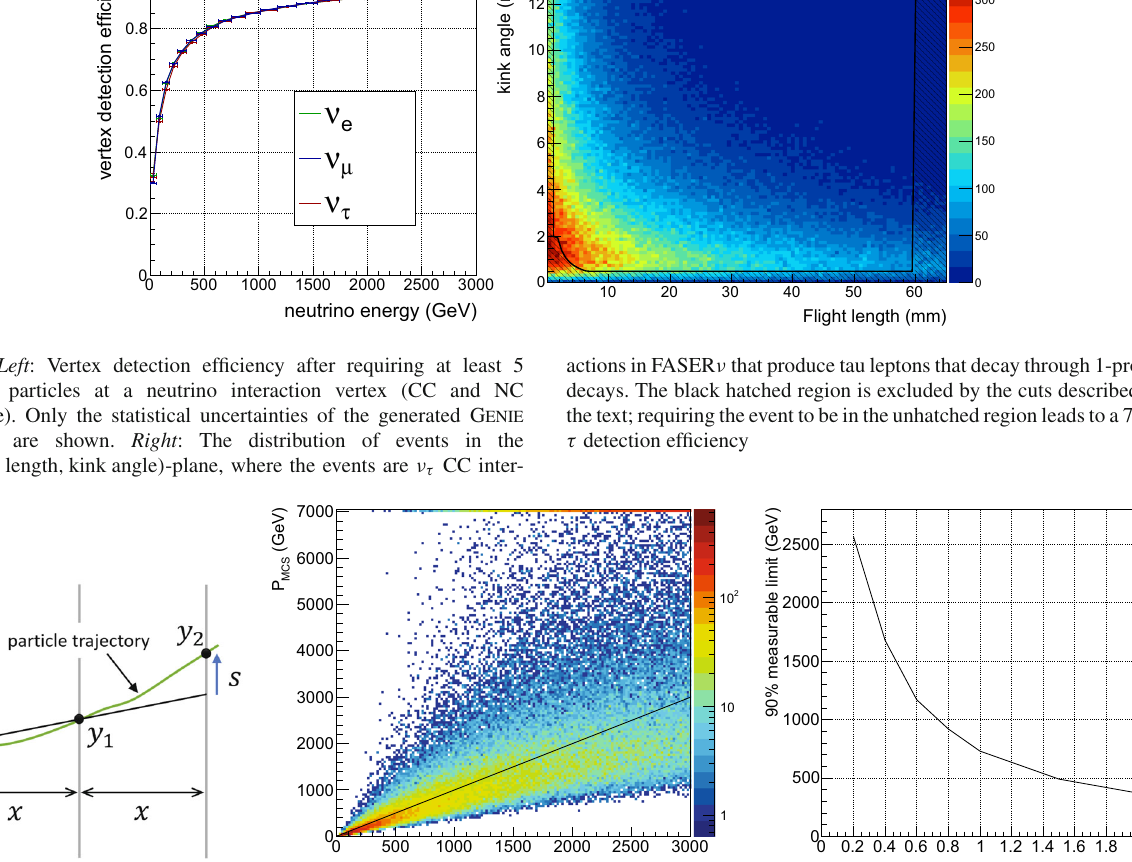
Right : The largest momentum for which the MCS method is applicable as a function of position resolution. The largest momentum is defined to be the momentum for which 90% of the particles’ momenta are recon- structed to have P MCS < 7